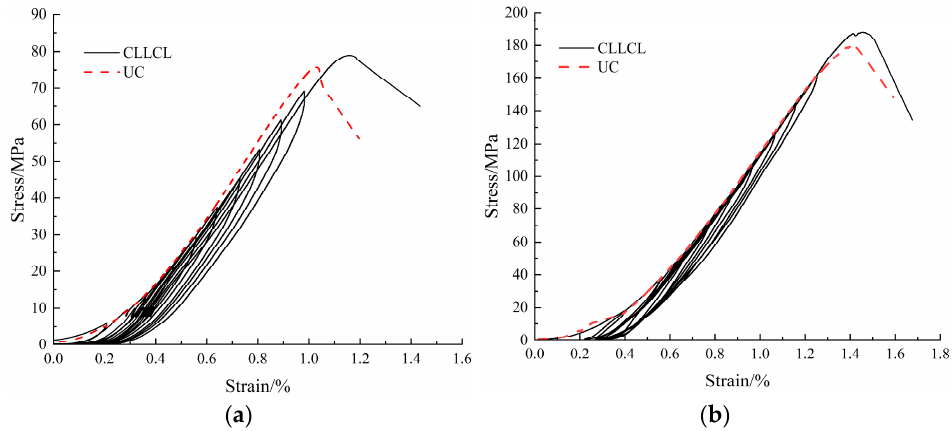
Figure 5. Stress–strain curves under CLLCL. ( a ) Sandstone; ( b ) granite.